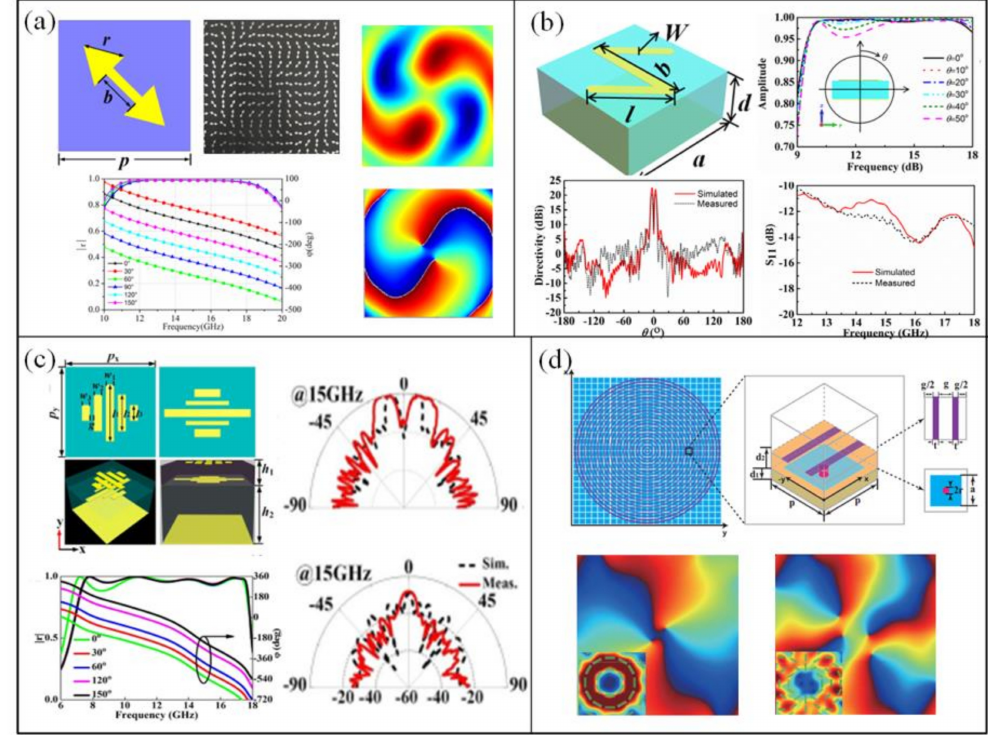
Figure 9. Reflective OAM metasurfaces based on geometric (PB) phase. ( a ) Double arrow-shaped metasurface [55]. ( b ) N-shaped resonator metasurface [56]. ( c ) Double-layered cross dipoles metasurface for a wideband vortex beams [57]. ( d ) OAM metasurface based on perfect electric conductor-perfect magnetic conductor (PEC-PMC) elements